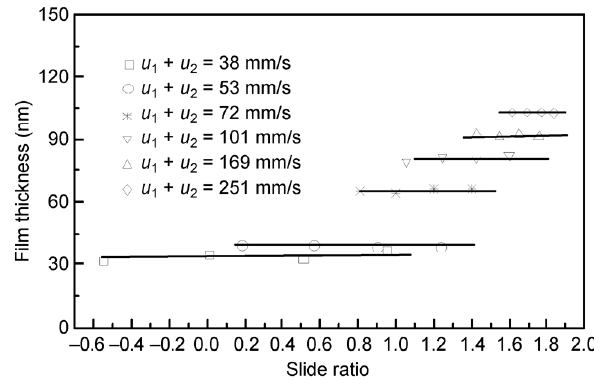
Fig. 16 Effect of slide ratio on the film thickness of white oil +5% nonionic acid, at a temperature of 20 ° C and load of 2 N, reported by Luo et al. [4, 38].